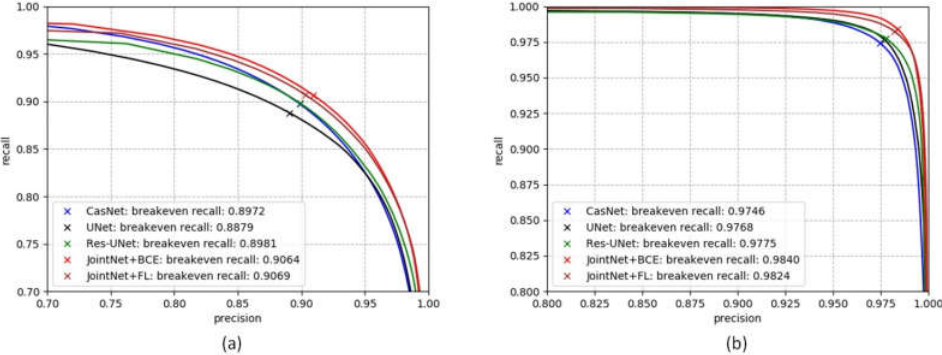
Figure 9. Precision/recall plots of CNNs performance on National Laboratory of Pattern Recognition (NLPR) road datasets: ( a ) The standard precision/recall plots. ( b ) The relaxed ( ρ = 3) precision/recall plots.